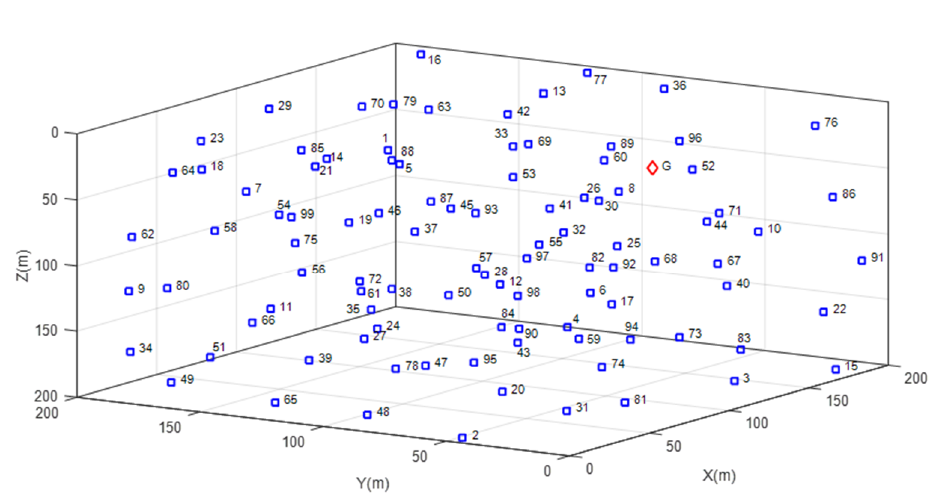
Figure 1. Network Model with 99 sensor nodes (labelled 1–99) and a sink node (labelled G).